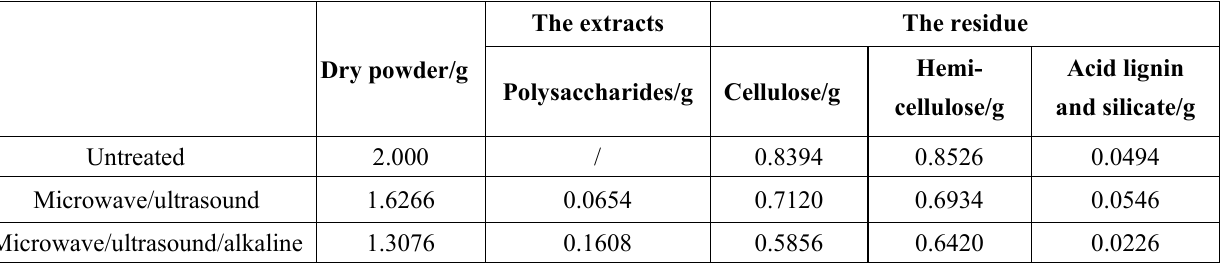
Table 2. The main chemical components of Ganoderma lucidum before and after alkaline extraction.